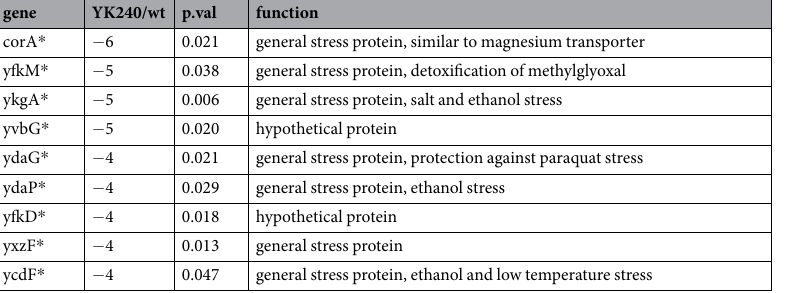
(Table 1, Table S1). Apparently, the cell division defect caused by SepF overproduction does not seem to originate from the repression of WalR. Almost ¾ of the 54 down-regulated genes belong to the SigB regulon. Normally expression of the general stress sigma factor SigB is triggered by a wide variety of intra- and extracellular stresses among which membrane integrity affecting substances such as ethanol 38 . Why the production of large membrane invaginations by SepF would reduce rather than induce the SigB stress response is unclear.